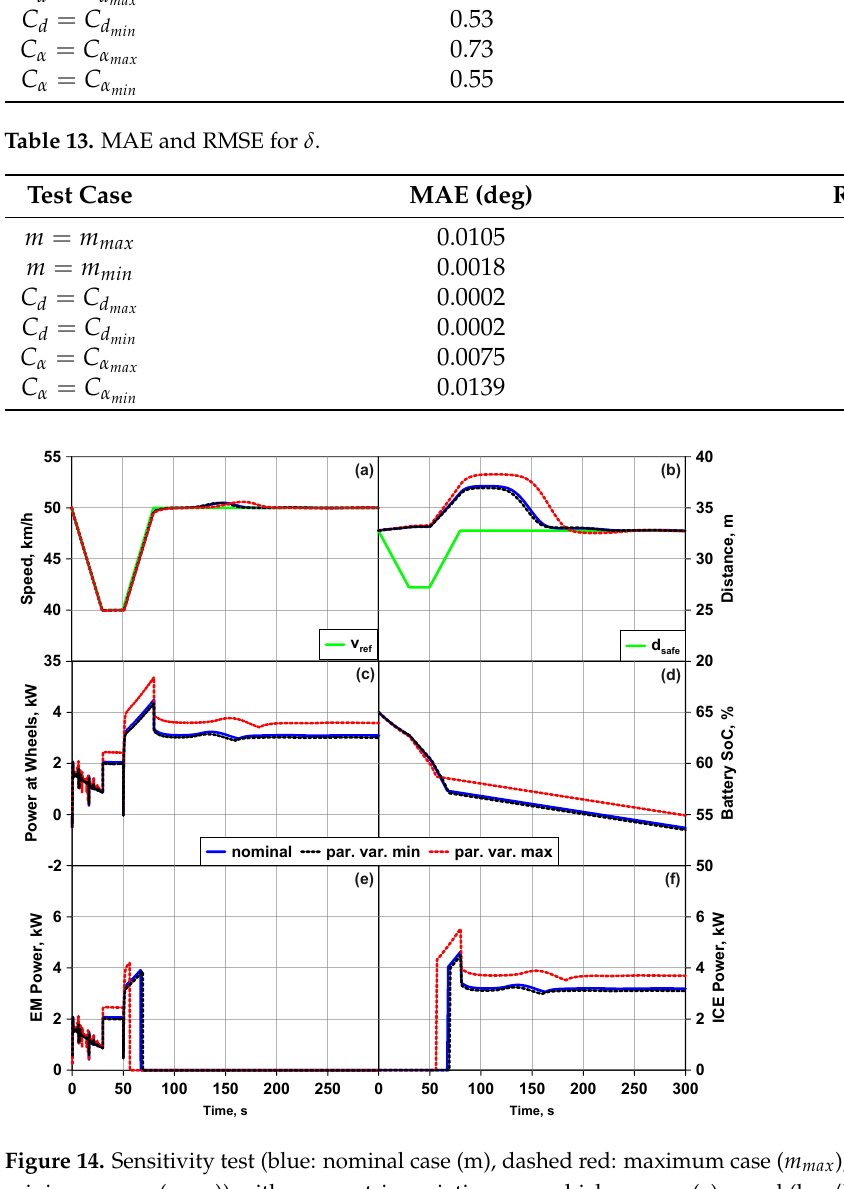
Figure 14. Sensitivity test (blue: nominal case (m), dashed red: maximum case ( m max ), dashed black: minimum case ( m min )) with parametric variations on vehicle mass—( a ) speed (km/h); ( b ) relative distance (m); ( c ) wheels power (kW); ( d ) battery SoC (%); ( e ) EM power (kW); ( f ) ICE power